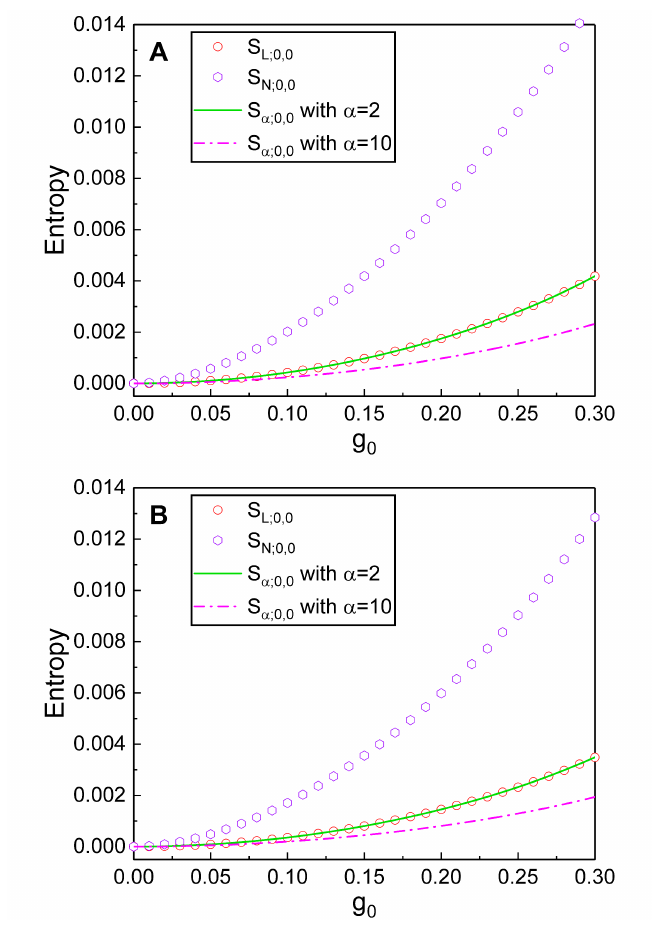
( t ) , S ( t ) , and S ( t ) α ;0,0 L ;0,0 N ;0,0 . 0 = 1, ¯ ω = 3, and ν ≡ ¯ (cid:34)/(cid:34) = m,0 c,0